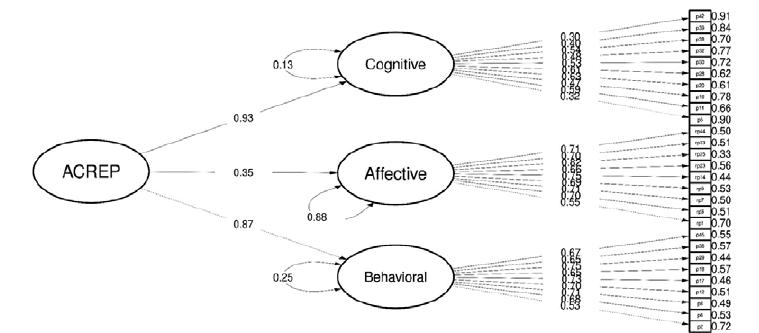
Figure 1. Confirmatory factor analysis: first order model (source: created by authors) Note: ACREP – attitudes towards creative